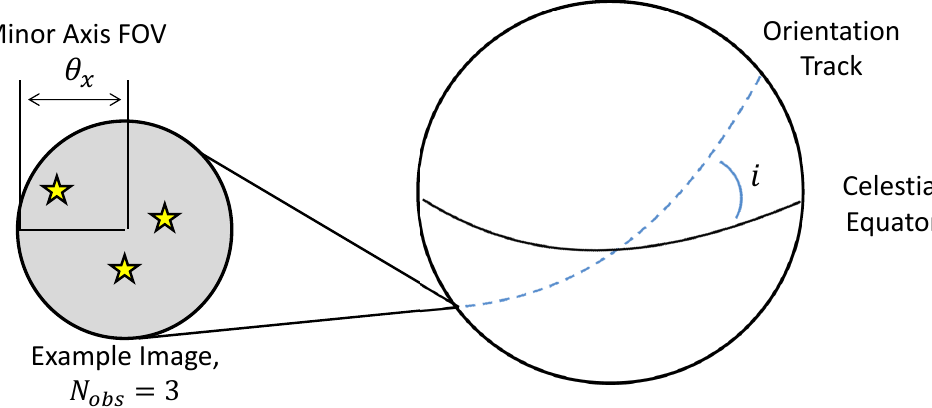
Figure 15. Schematic of orientation tracks for along-track dynamic availability.